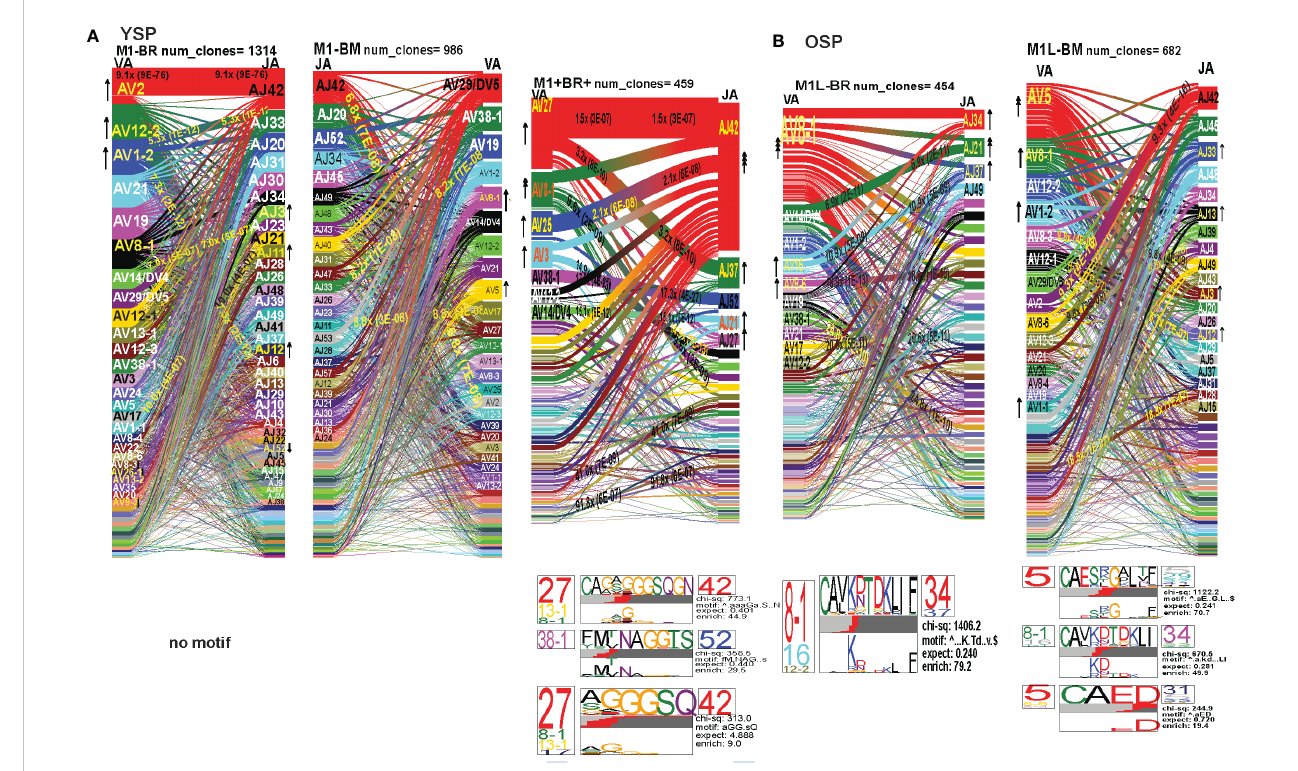
FIGURE 8 The hierarchy of AV and AJ gene pairing and CDR3 motifs of cross-reactive M1BM, M1BR, and M1+BR+ CD8 T cell populations differ from cognate and between young (A) and older donors (B) . This was determined after TCR high throughput sequencing of tetramer-sorted CD8 T cells in Y and O donors (Y, n=4; O, n=4-5) using ribbon-plot analyses (6, 8). The fi gure legends of Figures 6, 7, provide a detailed description of the ribbon-plot analyses that is applicable to this fi gure. M1BM or M1BR are cross-reactive EBV-BM or EBV-BR tetramer+ cells sorted from IAV-M1 stimulated short term cultures. M1 +BR+ are double tetramer+ co-staining CD8 T cells sorted from the IAV-M1 short-term